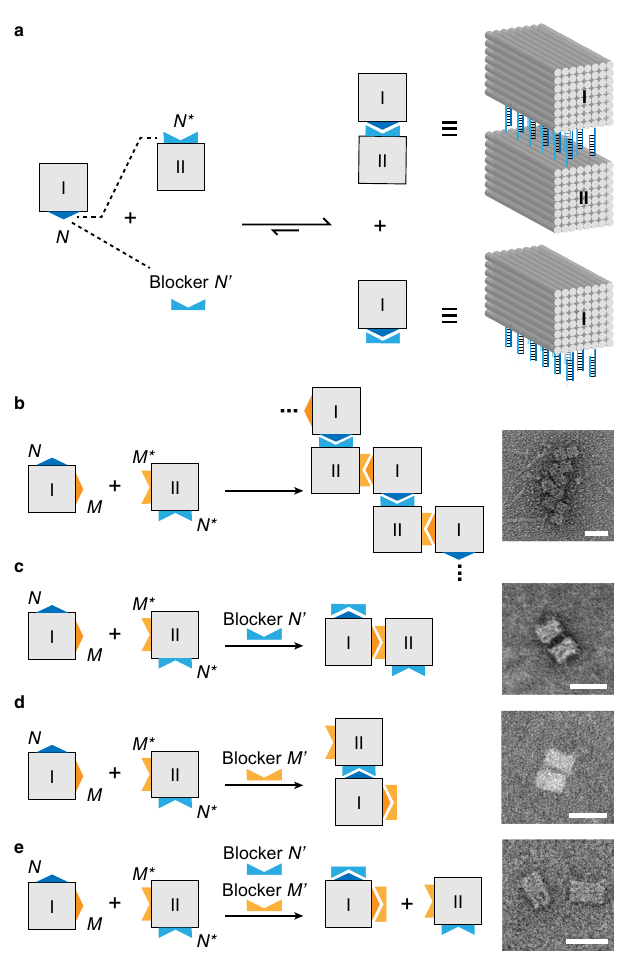
Fig. 4 Boolean functions implemented on a dual-unit 3D DNA nanostructure system. a Schematic diagram of ON/OFF binding switch of two cuboid origami units (8H×8H×10T): the binding of cuboids I and II in the absence of blockers (as ON) and the displacement in the presence of blockers (as OFF). b – e Boolean function of 4-bit input and 2-bit output. 4-bit input comprises system state of 2 bits ( NN * and MM *) of two units and controller of 2 bits (blockers N ’ and M ’ ). 2-bit output is read out as the resulted shapes (multimer, dimer or monomer) under TEM. Scale bars: